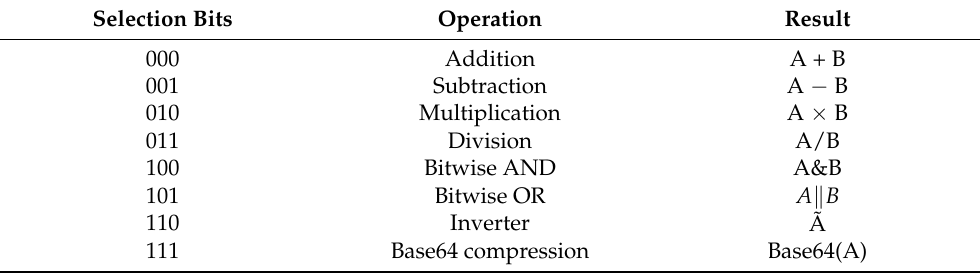
Table 2. ALCU and its